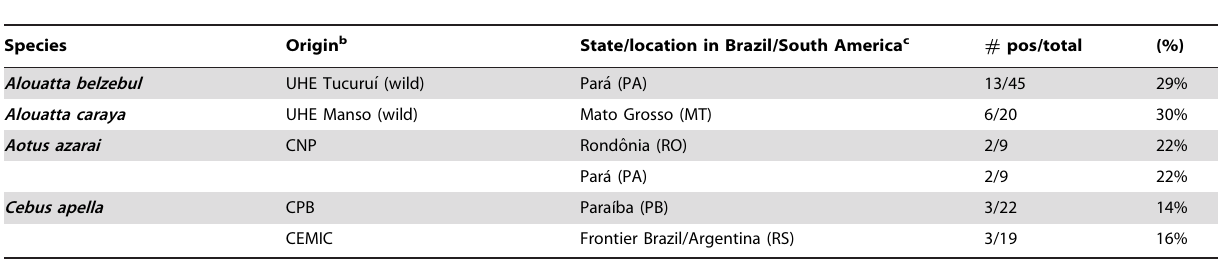
Table 1. SFV PCR prevalence in NWP living at primate centers and in the wild a .